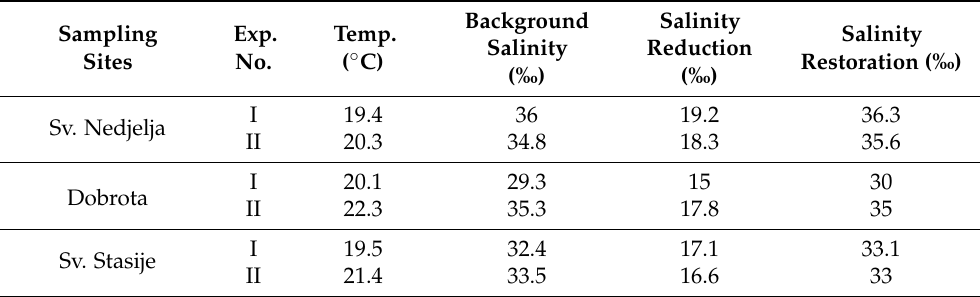
Table 1. Seawater temperature and salinity in aquaria with Pinna nobilis specimens sampled from the sites Sv. Nedelja, Dobrota and Sv. Stasije, measured before hyposalinity test (background), during the 50% reduction by distilled water (salinity reduction) and after the restoration by salt addition (salinity restoration). Abbreviations: Exp.—experiment; Temp.—temperature. Sampling Exp. Temp. Sites No. ( ◦ C)